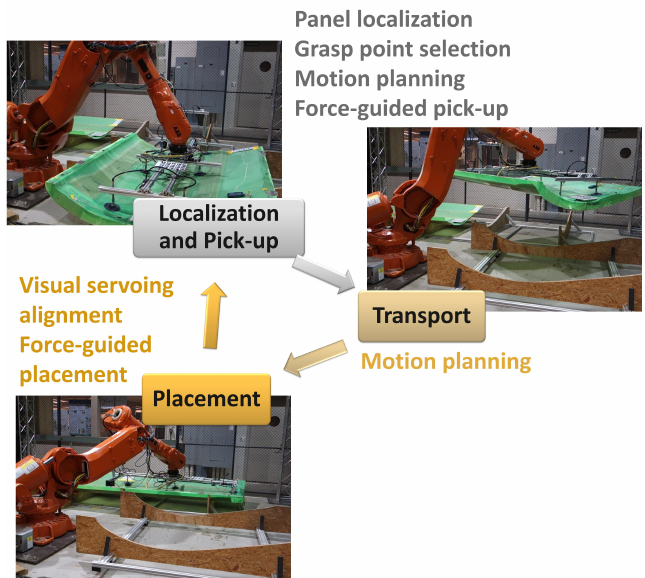
Figure 2. The assembly process consists of three major steps: panel localization and pick-up, panel transport, and panel placement. Vision feedback is used for localization and alignment. Force feedback is used for gentle contact and placement. Motion planning is required for collision-free panel